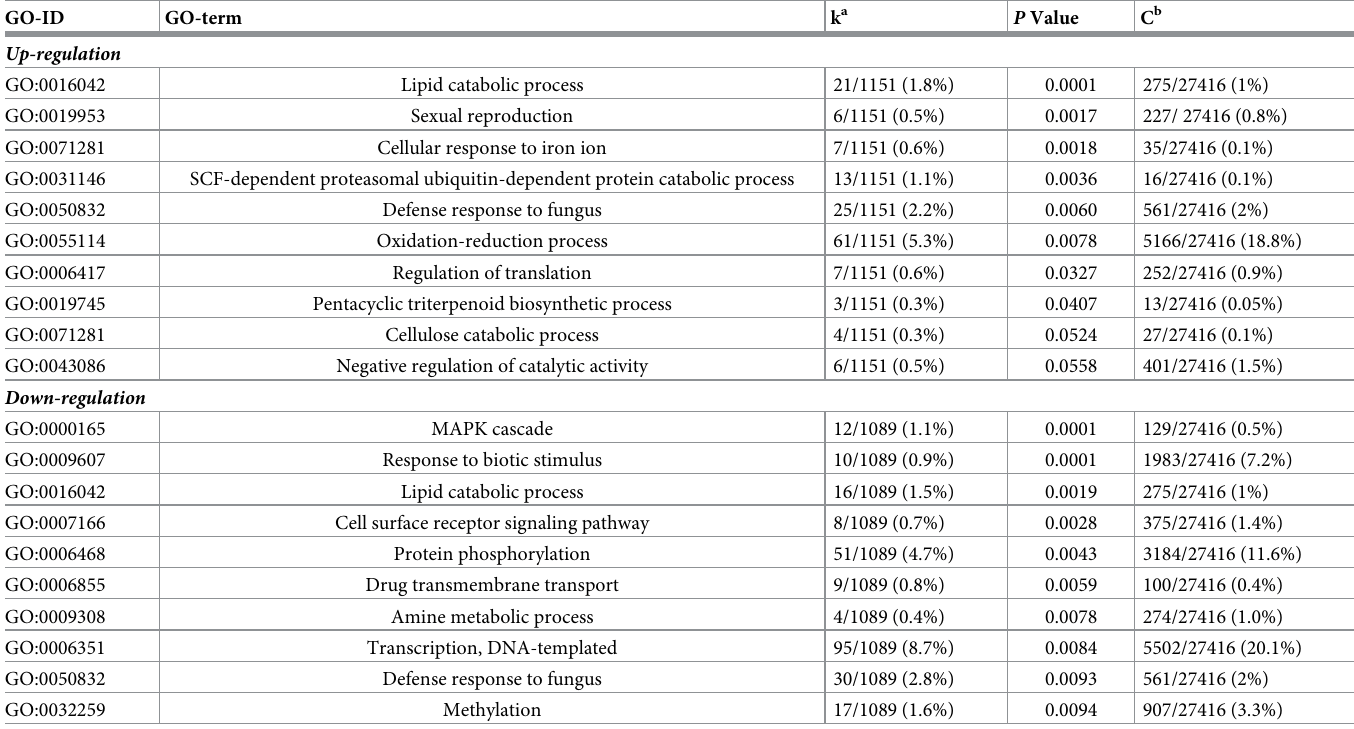
Table 1. Top 10 gene ontology (GO) terms in the biological process category affected by gamma irradiation.